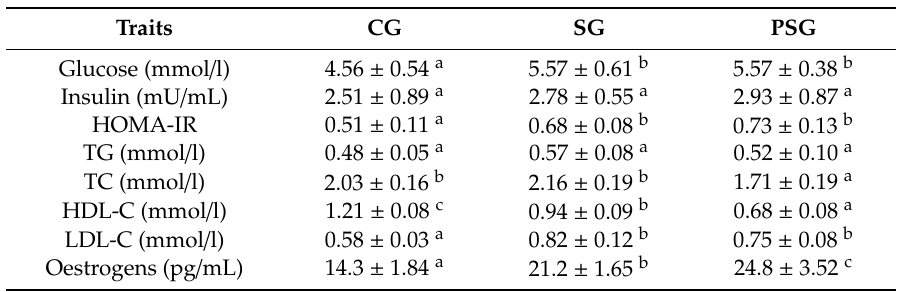
Table 3. E ff ect of frequent changes in diet or periodic starvation on glucose, insulin, lipid concentrations and HOMA-IR value in the examined rats.